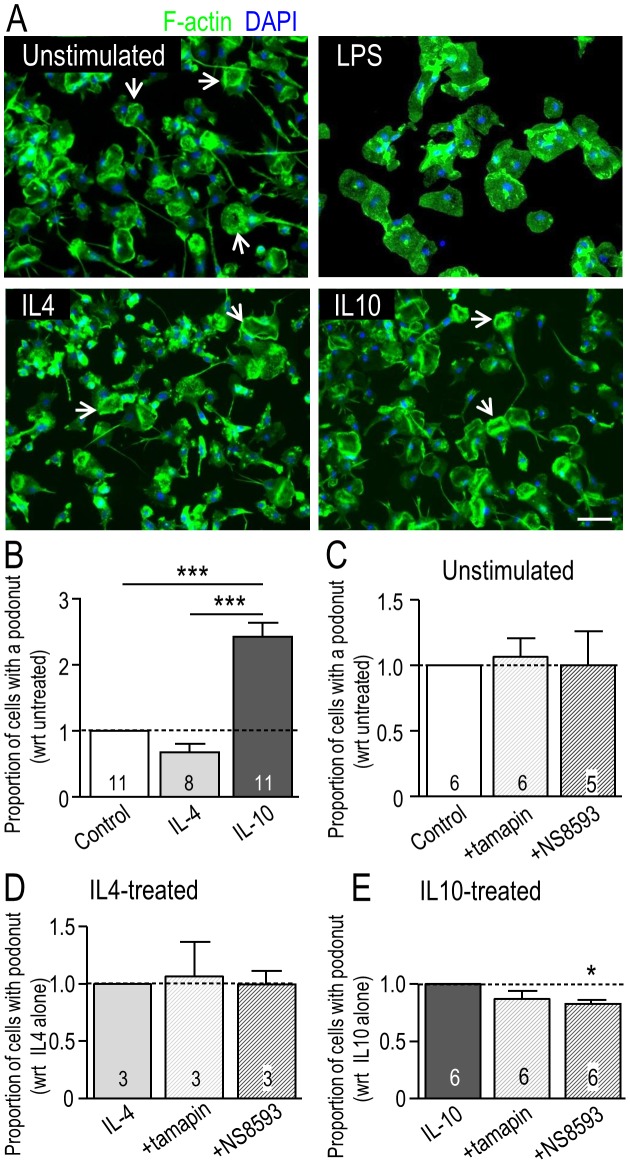
Effect of microglial activation state and selected channel inhibitors on podosome (podonut) expression.
A. Representative fluorescence micrographs show podonut expression in unstimulated primary rat microglia or 24 hr after treatment with LPS (10 ng/ml), IL4 (20 ng/ml) or IL10 (20 ng/ml). The arrows indicate examples of a single, large donut-shaped ring of podosomes, which we call a ‘podonut’ in the lamellum of unipolar microglia. Cells were stained for filamentous (F-) actin with phalloidin (green) to quantify the proportion of cells with a podonut, and with the nuclear marker, DAPI (blue) to quantify total cell numbers. Scale bar, 50 µm. B. Podosome (podonut) expression is affected by the microglial activation state. The proportion of microglial cells bearing a podonut in the lamellum (sum of 3 randomly selected fields of view at 10× magnification) was normalized to unstimulated cells. C–E. Microglia were unstimulated or stimulated for 24 hr with 20 ng/ml IL4 or IL10, and then exposed for 6 hr to control medium or the KCa2.3 inhibitors, 5 nM tamapin or 7 µM NS8593, which also inhibits TRPM7 channels (see Results and Figs. 6, 7). All graphical data are shown as mean ± SEM with sample size (# of individual cultures) indicated on each bar. A one-way ANOVA with Tukey's post-hoc analysis was used to determine significant differences. *p<0.05; ***p<0.001.